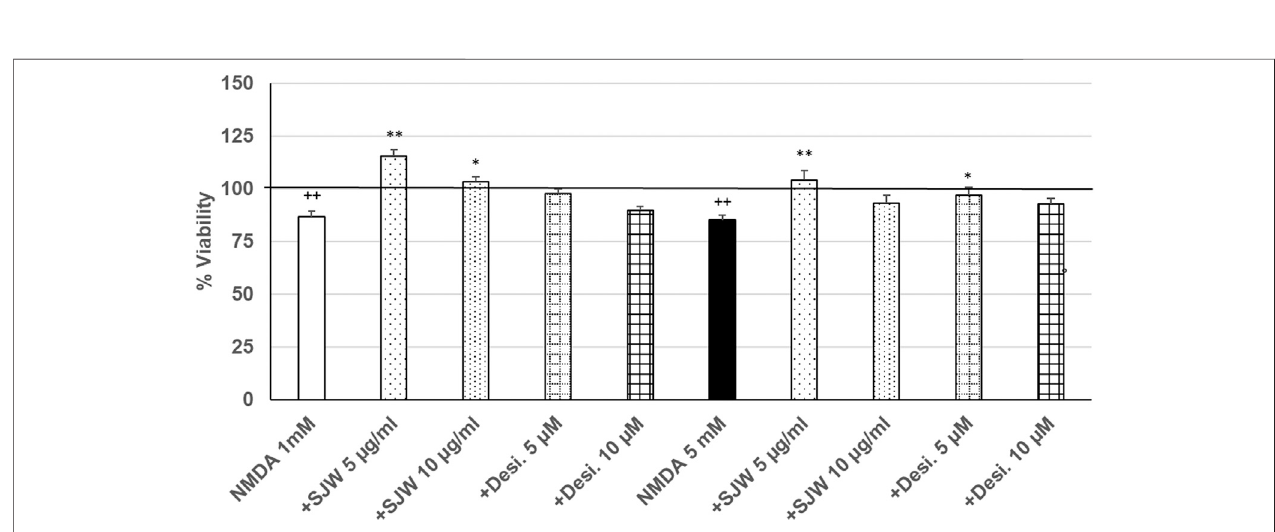
FIGURE 6 | Effects of48 pre-treatment with STW3-VI [St. John ’ swort(SJW)] or desipramine and afterwards 24 h co-incubation with N-methyl-D-aspartate (NMDA) (1 or 5 mM)onviabilityofmouseSIM-A9microglia.ViabilitywasmeasuredbyPrestoBlue ® assay.Values[in%viabilityofuntreatedcontrol(control (cid:2) 100%viability)]aregivenasmean+ SEM; signi fi cance (by T-TEST): * p < 0.05, ** p < 0.01, vs. NMDA ++ p ≤ 0.01 vs. untreated control; ++ p < 0.01 vs. untreated control (100%); n (cid:2) 4 ‒ 12.